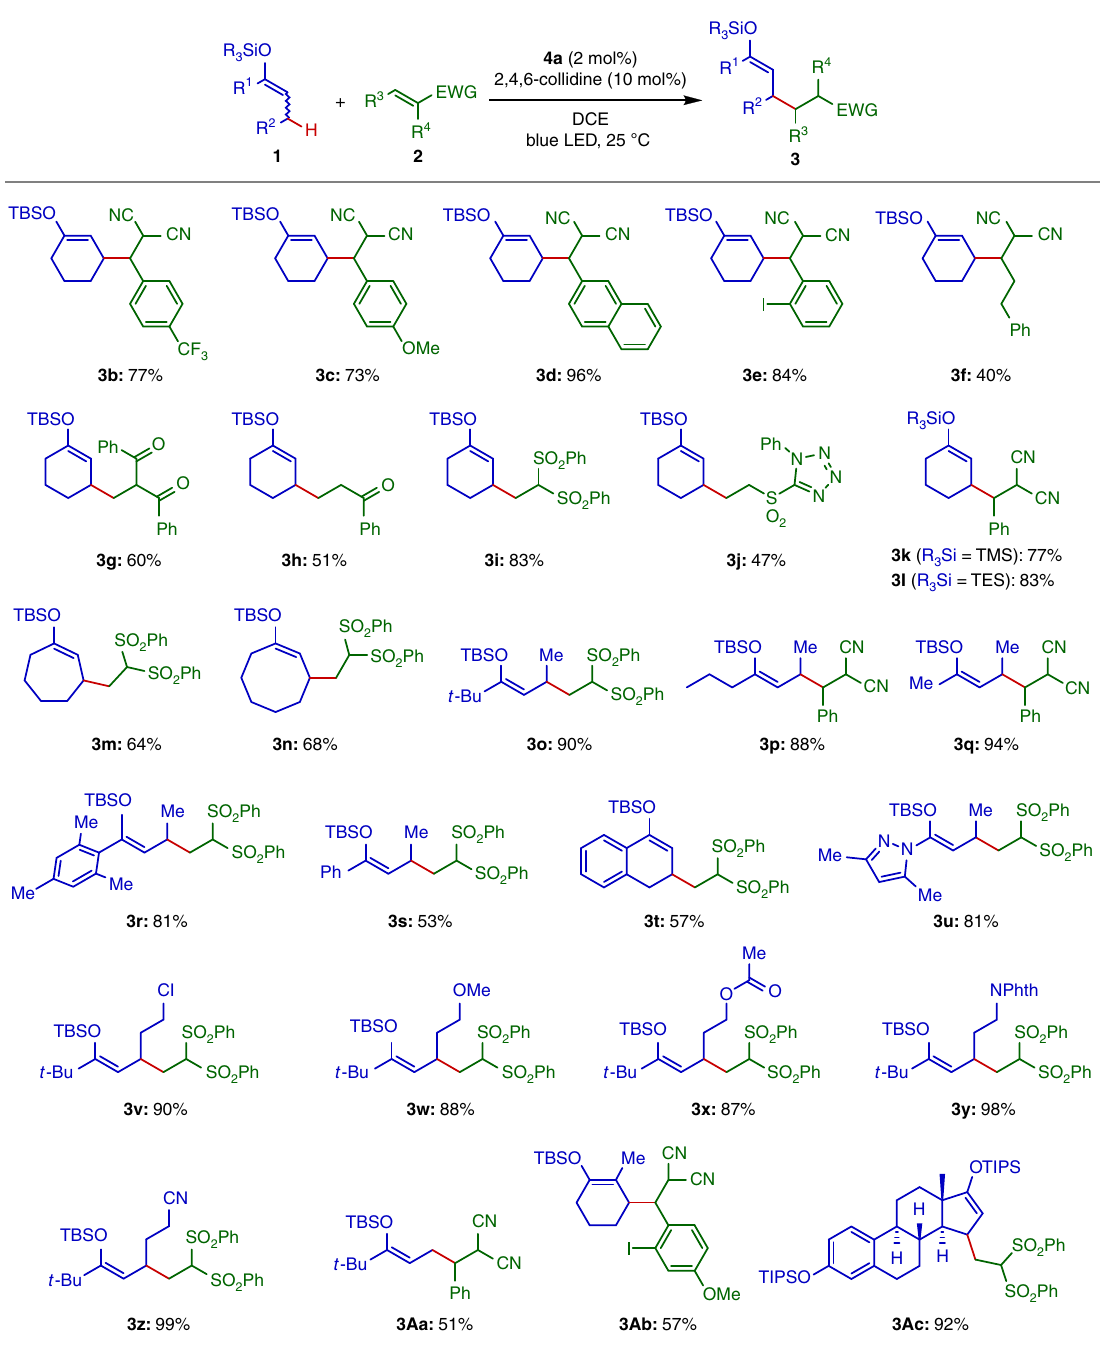
Fig. 3 Substrate scope. Isolated yields are shown. Diastereomeric ratios (d.r.) of the products with consecutive two stereocenters were 1.5:1 – 2.0:1. See the Supplementary Information for